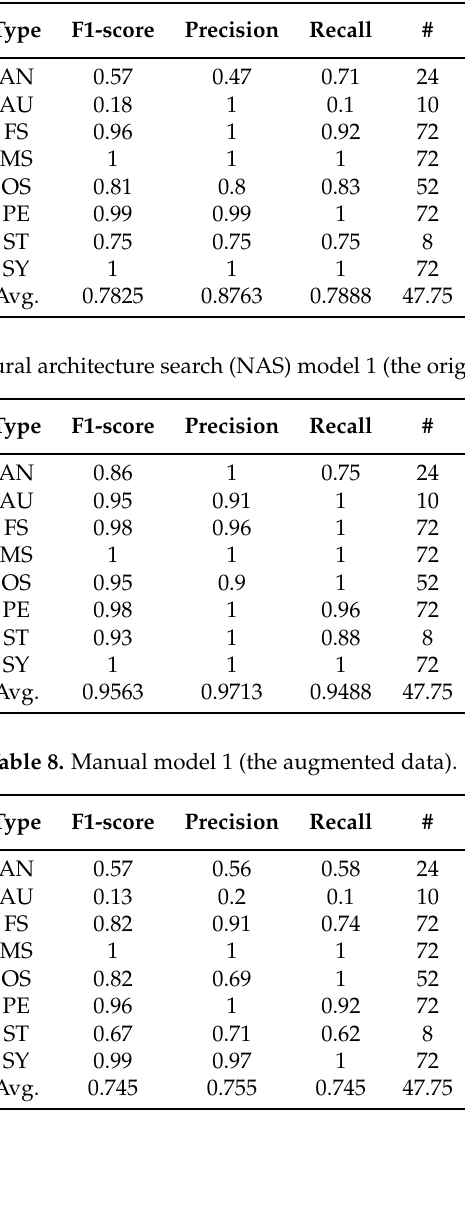
Table 6. Manual model 2 (the original data).